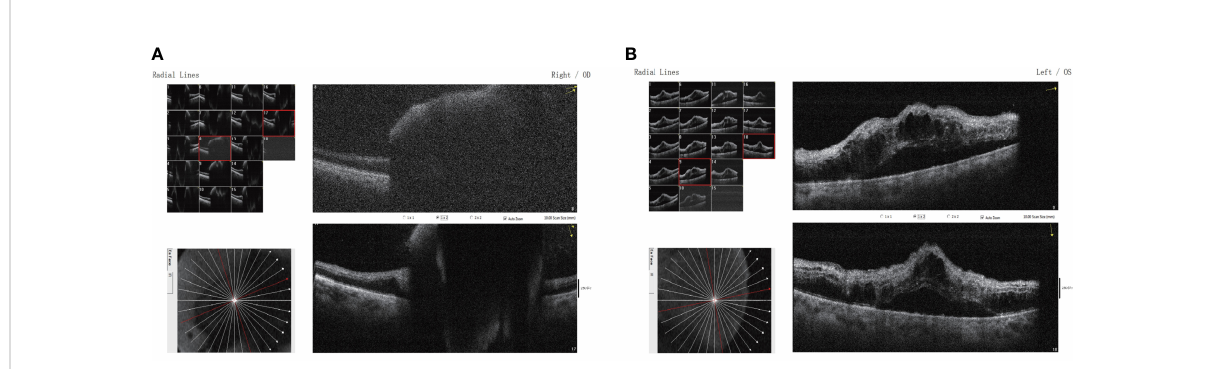
FIGURE 3 Binocular macular optical coherence tomography scanning through the (A) right and (B) left eyes showing a subretinal lesion of the right eye with elevated pigment epithelium and neuroepithelium in the macular region and mild cystic macular edema in the left